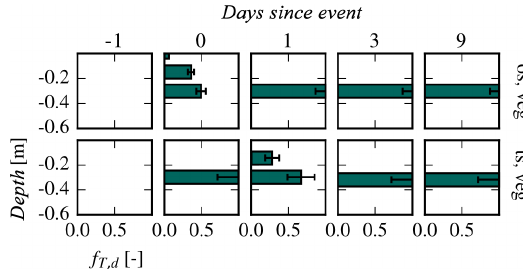
Figure 7. Mean daily fractions of root water uptake f T,d of un- derstorey plants for modelled soil depths. Numbers at the top mark days after watering event. Uncertainty bars display standard